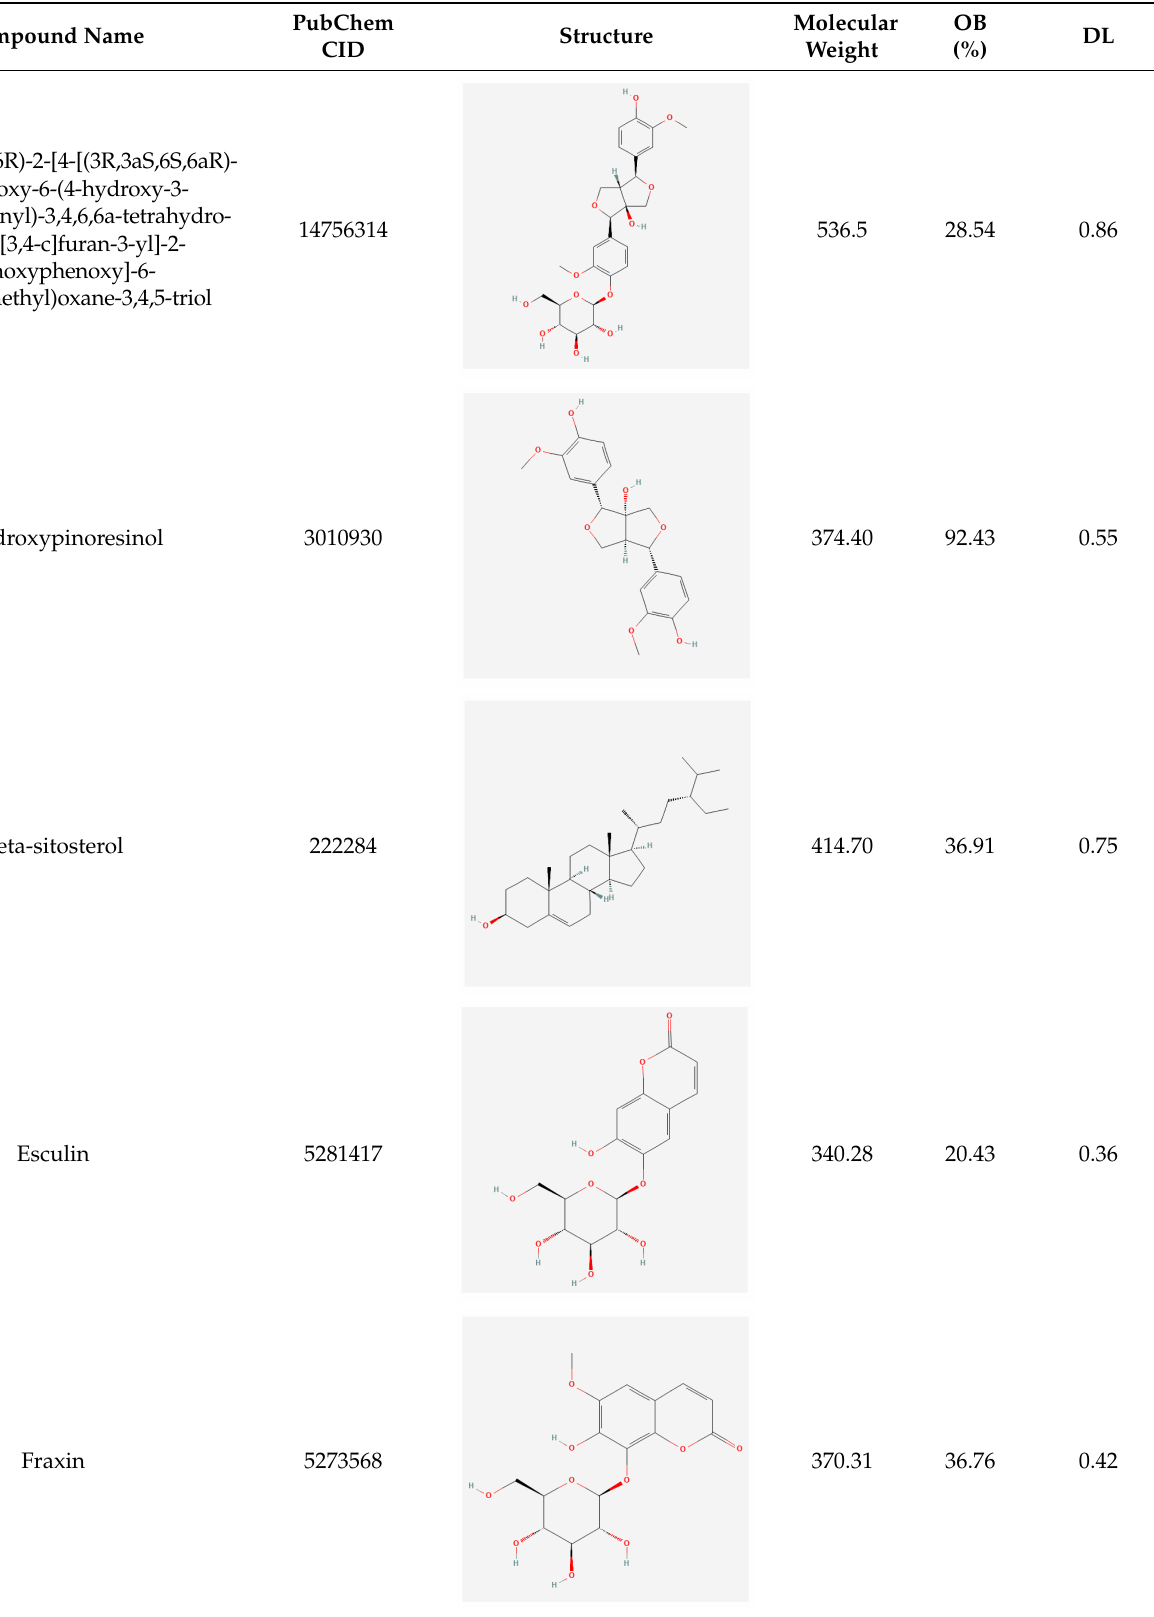
Table 1. Active compounds of F. rhynchophylla